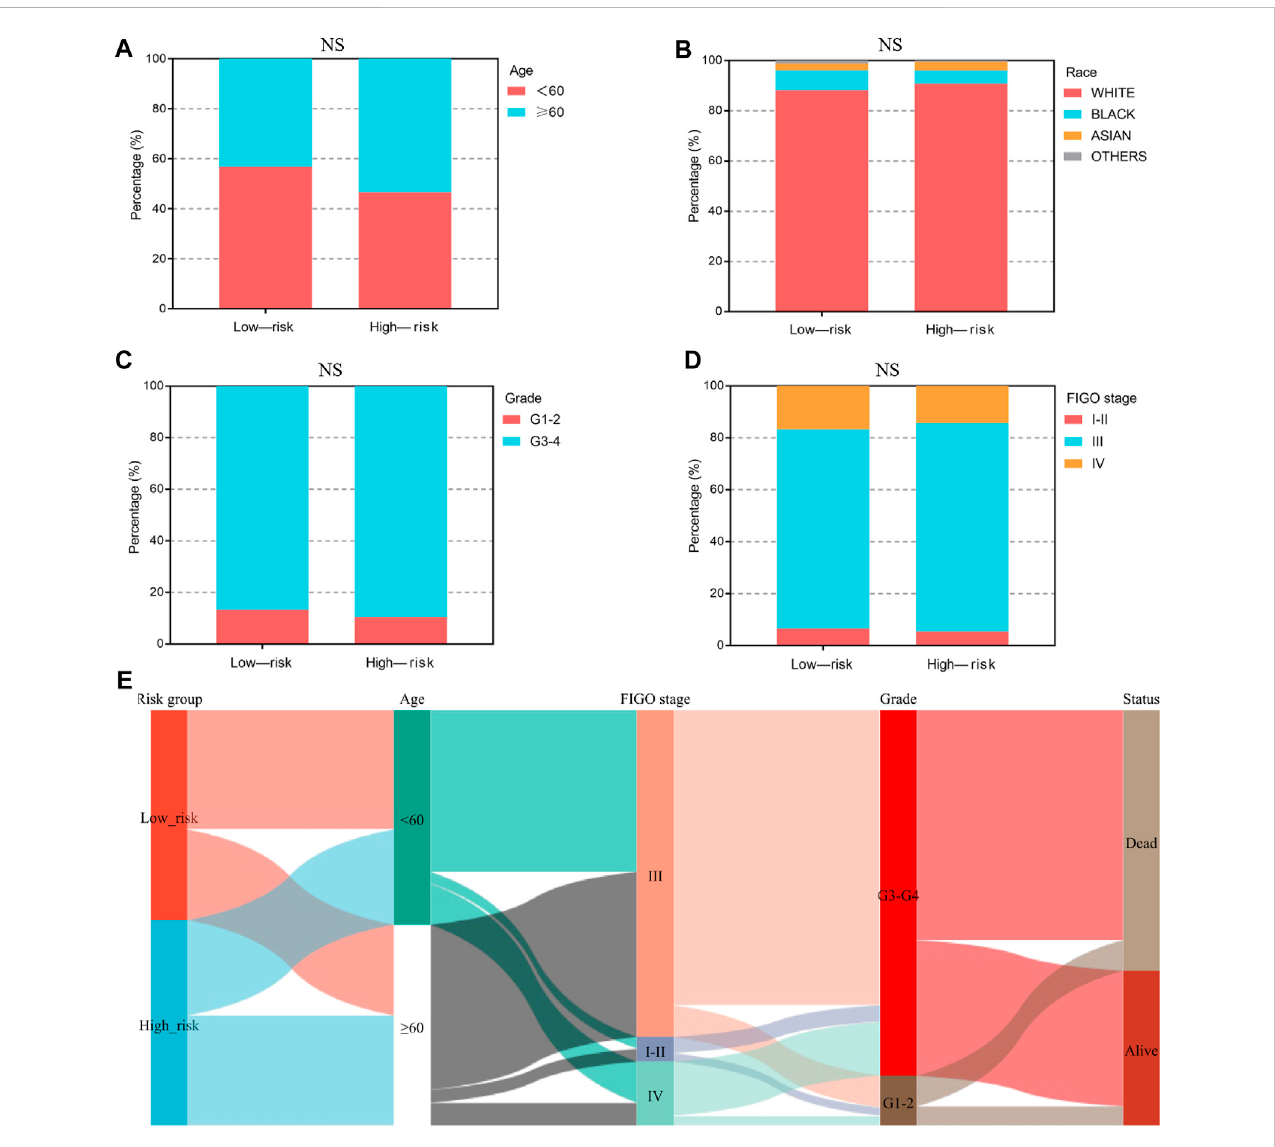
FIGURE 4 The clinical characteristics of OV patients, strati fi ed by the ferroptosis-associated 3-gene signature. (A – D) The stacked bar chart for clinical features distribution, including age, race, grade, and FIGO stage, among the low-risk and high-risk groups. The signi fi cance p -value was analyzed via the chi-square test. NS, no signi fi cance. (E) The Sankey diagram for features, including age, grade, FIGO stage, and the 3-gene signature. Each color represents different typing, each row represents a different variable, and each line represents the distribution of the same sample refer to different